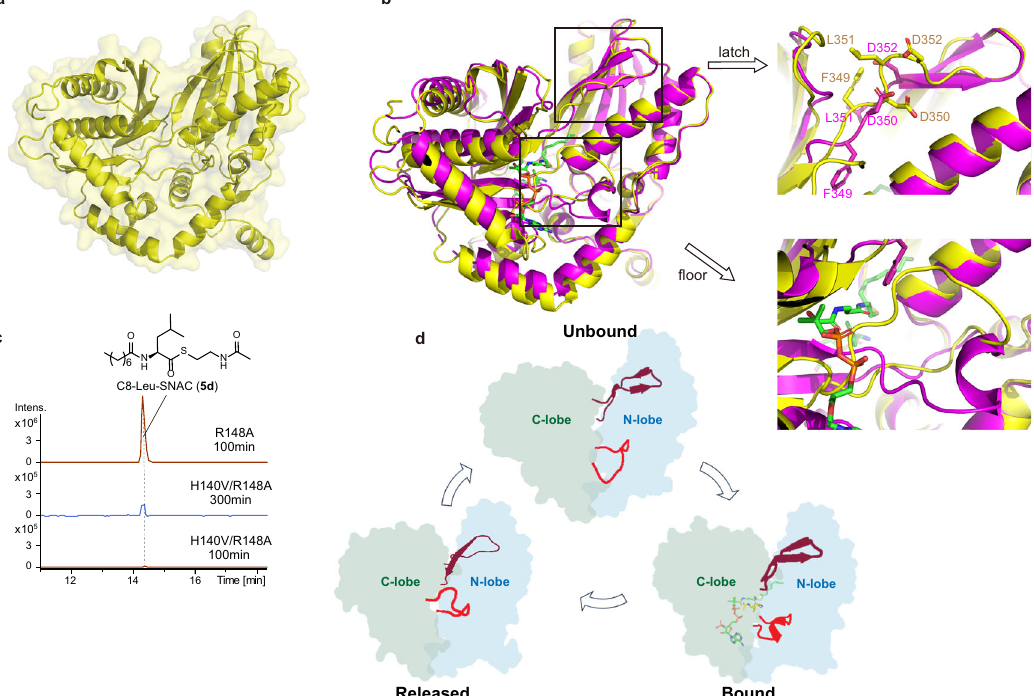
Fig. 9 Potential conformational changes within the reaction cycle of lipoinitiation. a The overall structure of RzmA-Cs H140V/R148A in a “ product- released ” state. b Superimposition of H140V/R148A structures in “ released ” (yellow) and “ bound ” (magenta) forms. Two enlarged views highlighting the changes in the “ latch ” and “ fl oor ” regions. c The comparative analysis of C8-Leu-SNAC ( 5d ) in vitro produced by RzmA-Cs mutants R148A and H140V/ R148A with substrates C8-CoA and L-Leu-SNAC. EICs at m / z = 359.2 ( 5d , [M + H] + ). d A schematic diagram showing the potential conformational changes of Cs domains during the reaction cycle, with the “ latch ” and “ fl oor ” regions (secondary structures in cartoon mode) highlighted in brown and red,